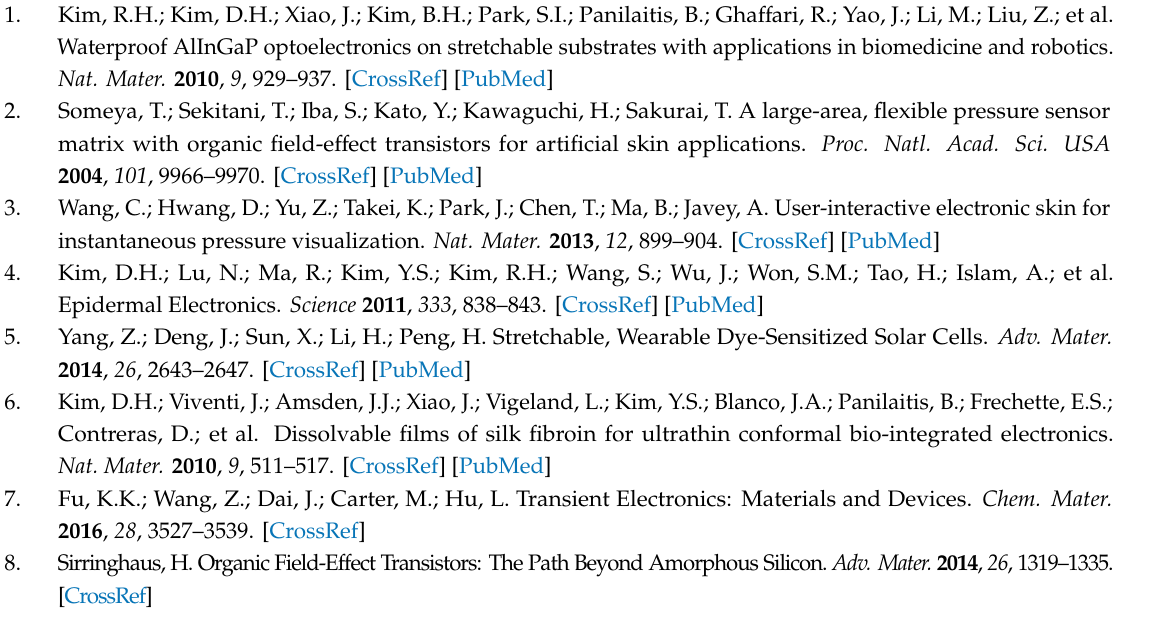
Figure S1: 1 H NMR and expanded 1 H NMR spectra of P3HT. Figure S2: Calculation of the POSS introduction rate. Figure S3: 1 H NMR spectrum of HDO. Figure S4: 1 H NMR spectrum of PTMG. Figure S5: Identification of chemical shifts of protons in 1 H NMR spectrum of PUM. Figure S6: Identification of chemical shifts of protons in 1 H NMR spectrum of PUPOSS. Figure S7: In-plane conductivity of F4-TCNQ doped P3HT films. Figure S8: Photographs of hybrid films. Figure S9: SEM images of the surface of hybrid films (interface of hybrid film / PFA dish). The amount of doped P3HT loaded in all films is 20 wt %. Figure S10: SEM images and elemental mapping of the cross section of hybrid films. The amount of doped P3HT loaded in all films is 20 wt %. Right side of the images is the interface of hybrid film / air. Figure S11: Storage and loss moduli of (a) P3HT / PUPOSS and (b) P3HT / PUM at each amount of loaded doped P3HT. Figure S12: TGA curves of (a) P3HT / PUPOSS and (b) P3HT / PUM at each amount of loaded doped P3HT. Figure S13: In-plane electrical conductivity of P3HT / PUPOSS and P3HT / PUM loading 20 wt % of P3HT before and after thermal annealing. Figure S14: The relationship between conductivity and applied mechanical forces of P3HT / PUPOSS loaded 20 wt % of doped P3HT. Table S1: TGA data of hybrid